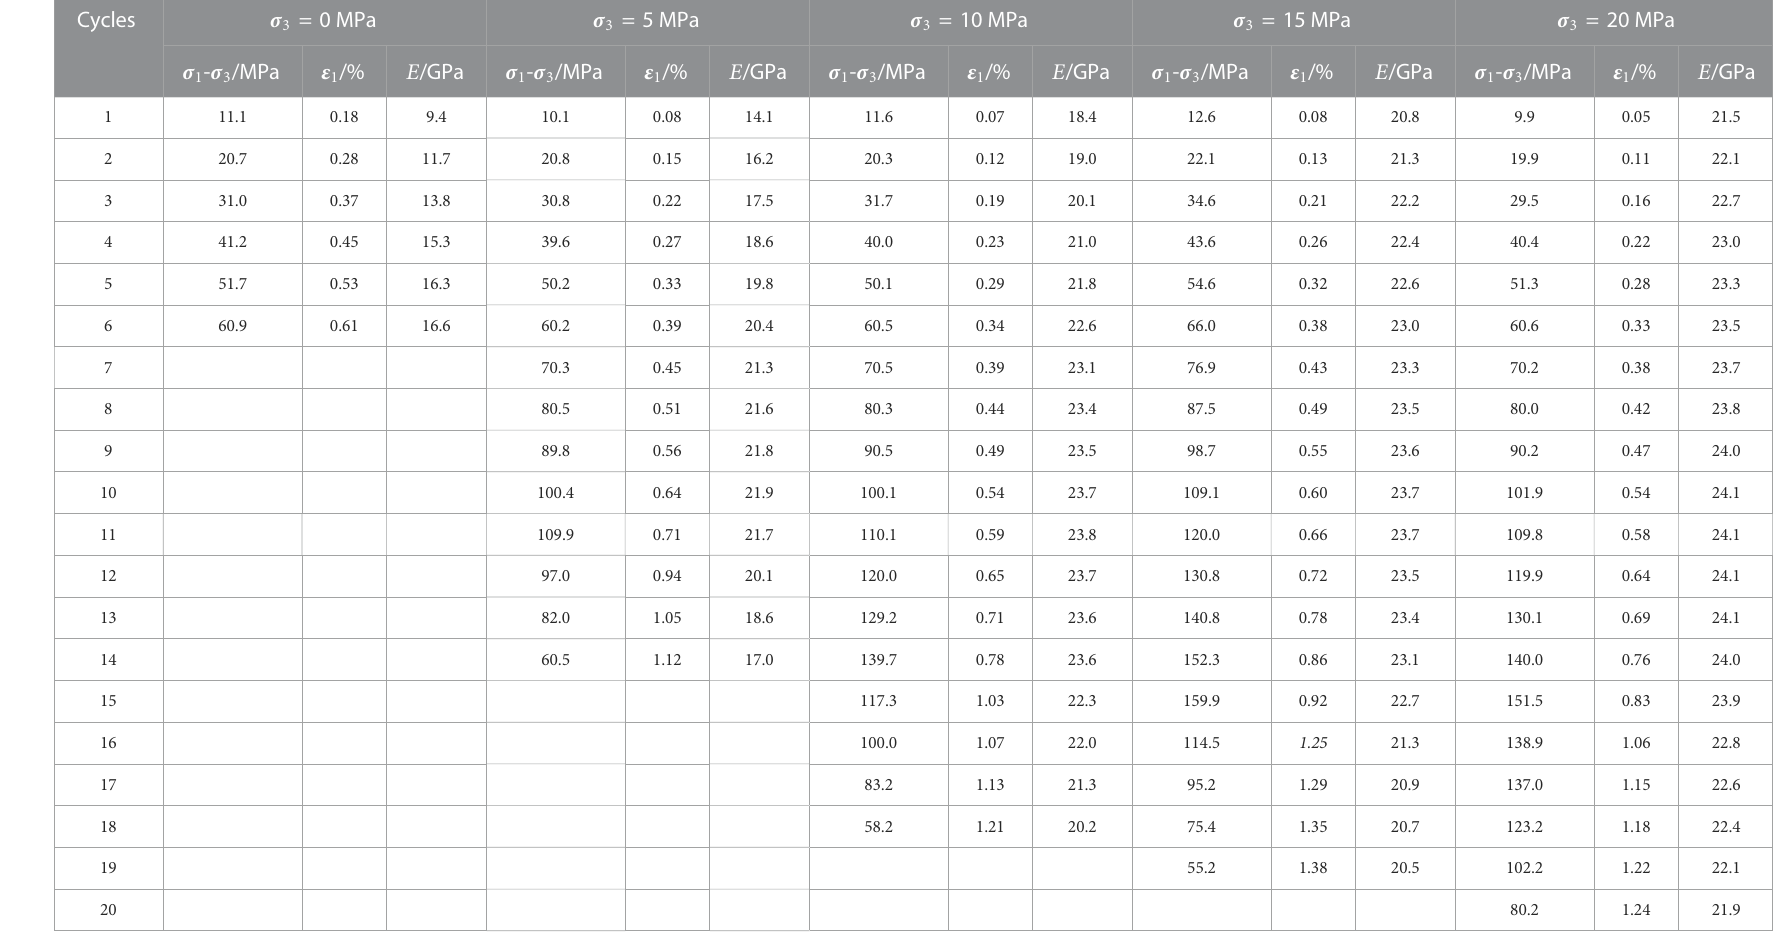
TABLE 3 Results of equivalent elastic